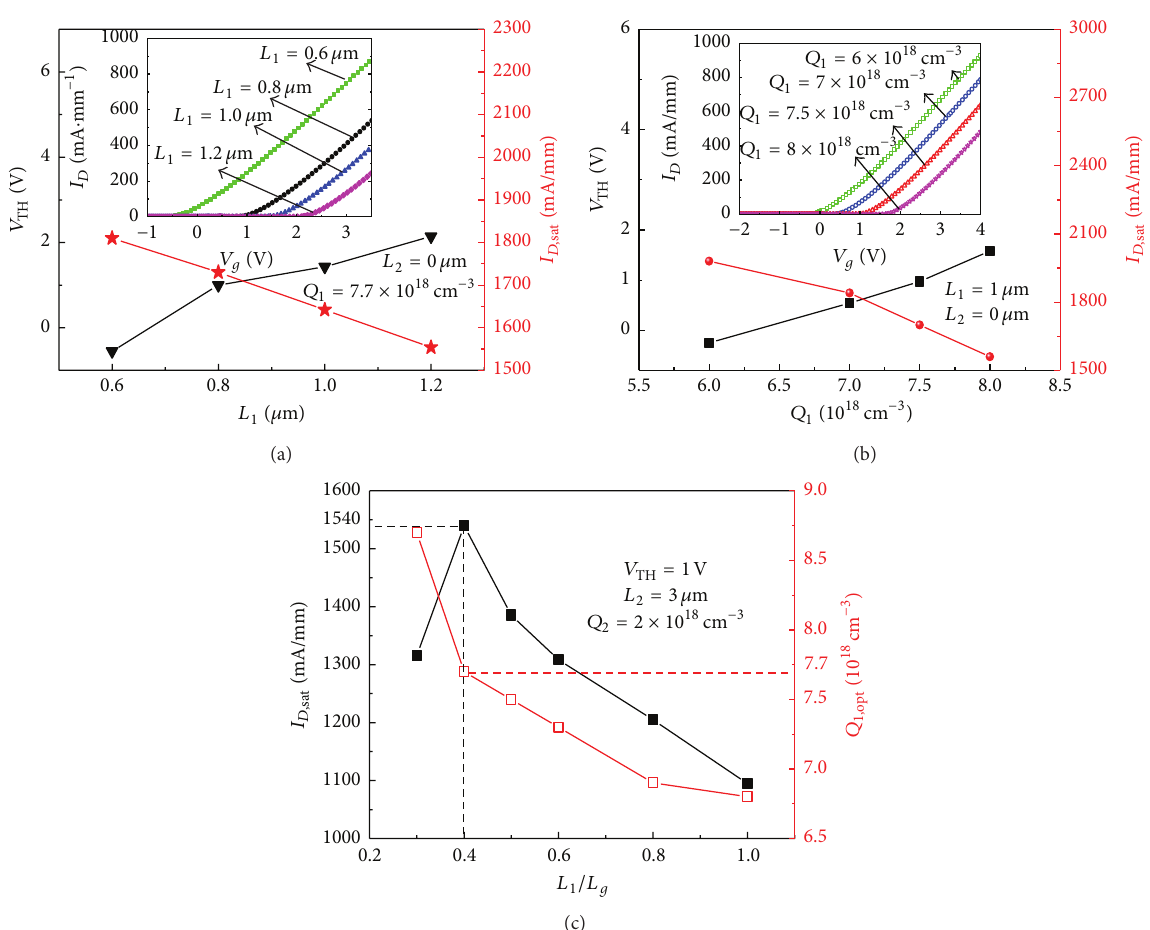
Figure 5: (a) Dependence of the 𝑉